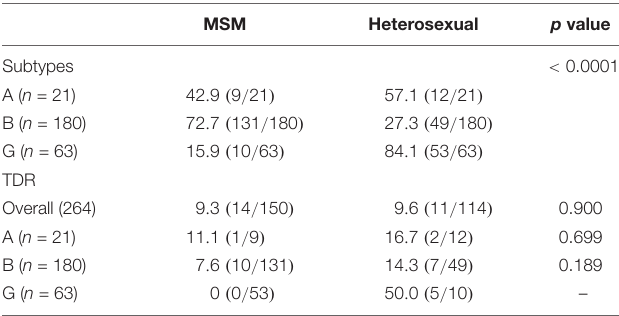
TABLE 4 | Characteristic of patients in HIV-1 molecular transmission clusters according to the transmission route.